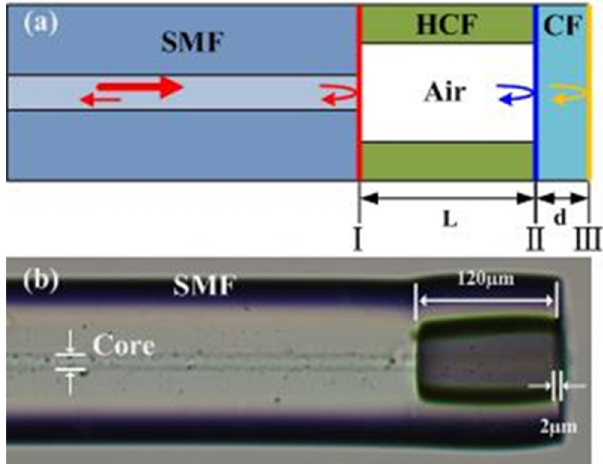
Figure 1. ( a ) Schematic and ( b ) microscope images of the proposed fiber tip all-silica Fabry–Perot interferometer (FPI) sensor.